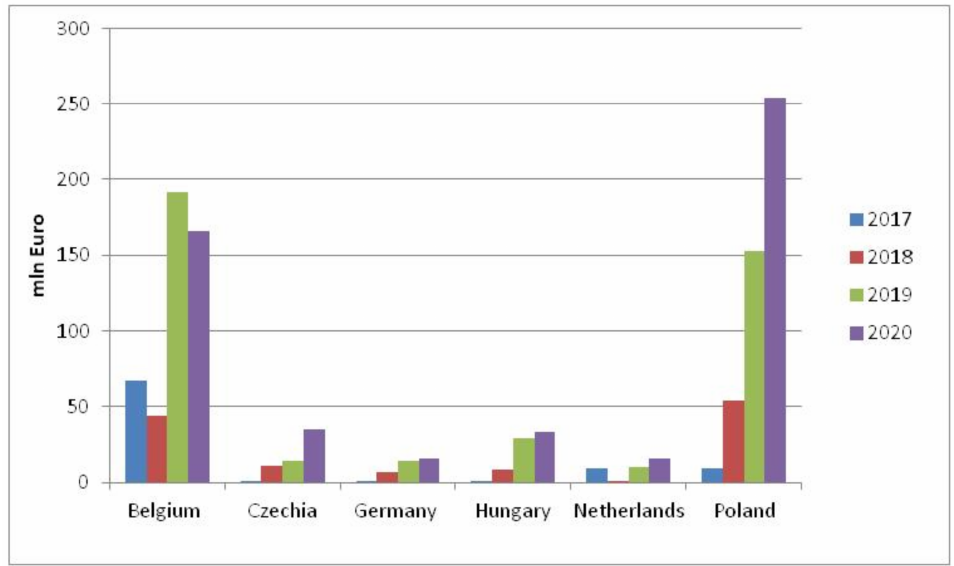
Figure 2. Exports of electric buses from main producing countries in the EU. Source of data: Eurostat COMEXT